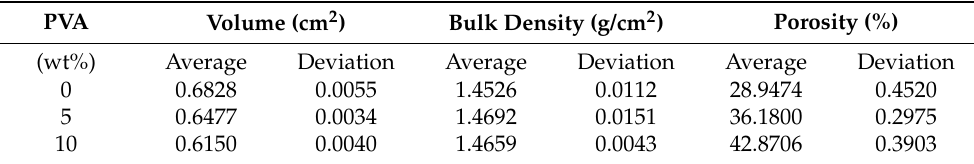
Table 1. The volumes, bulk densities, and porosities for SSD_P (x, y) (x = 0, 5, 10 wt%, y = 900 ◦ C) are measured by Archimedes principle with 6 sampling numbers (n =